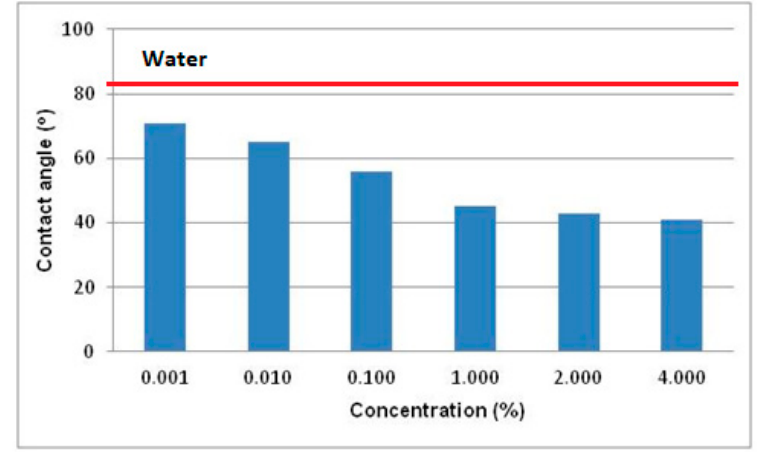
Figure 6. Dependence of contact angle ( θ ) of a steel surface wetted with aqueous solutions of sodium lauroyl sarcosinate as a function of surfactant concentration (c). Measurement temperature 20 °C, bearing steel (ŁH15—100Cr6—1.3505—high-carbon chromium bearing steel). Solid line describes the θ value for water (81°).